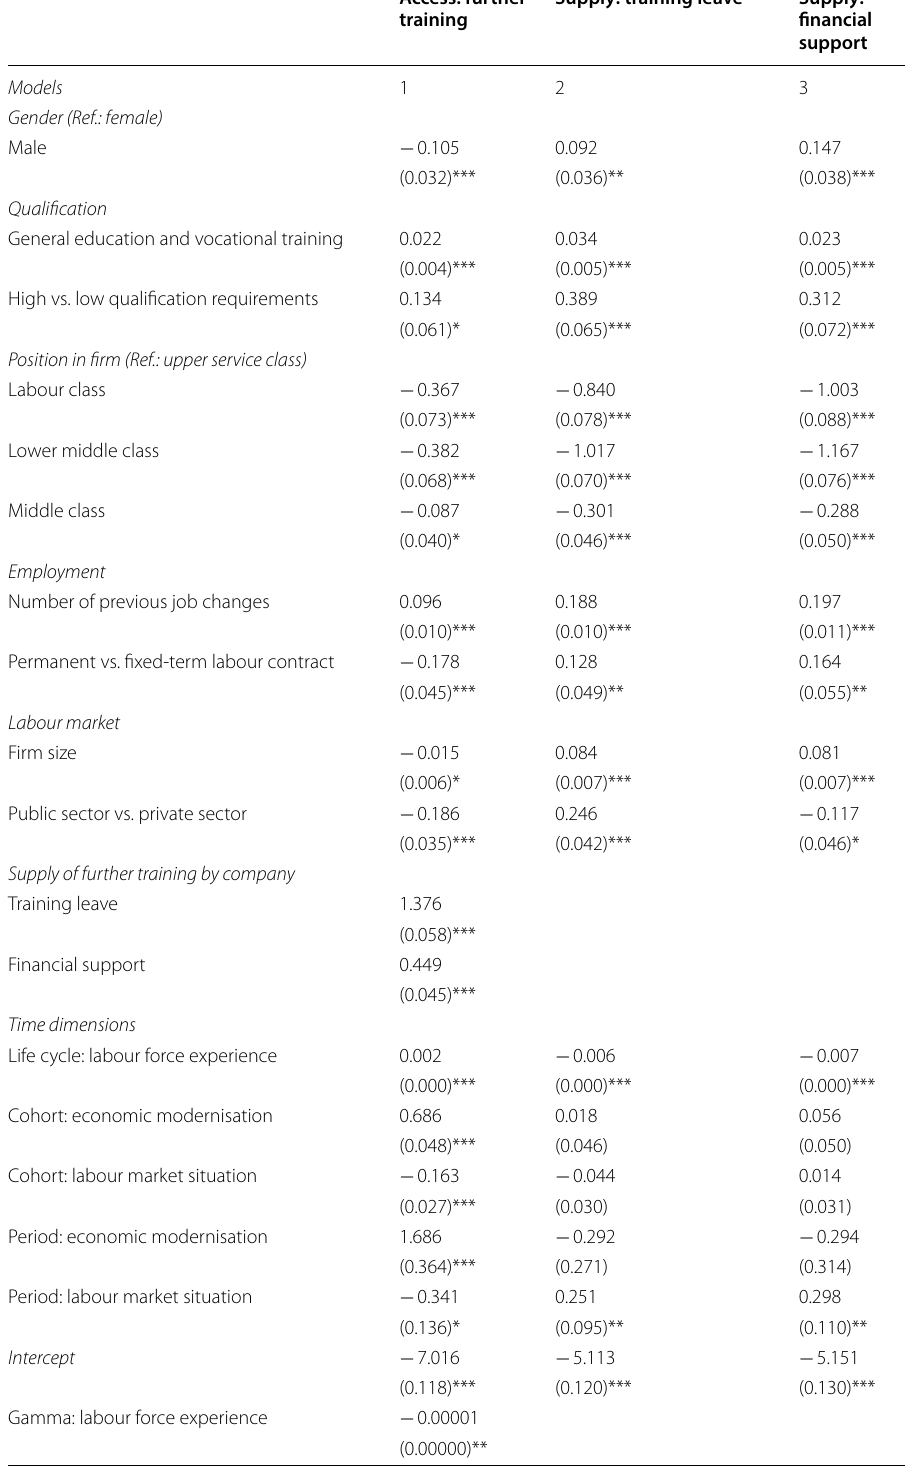
Table 2 Access to and participation in further training (Gompertz model) and the role of employers’ supply for employees’ participation in further training (exponential model) Access: further Supply: training leave Supply: training